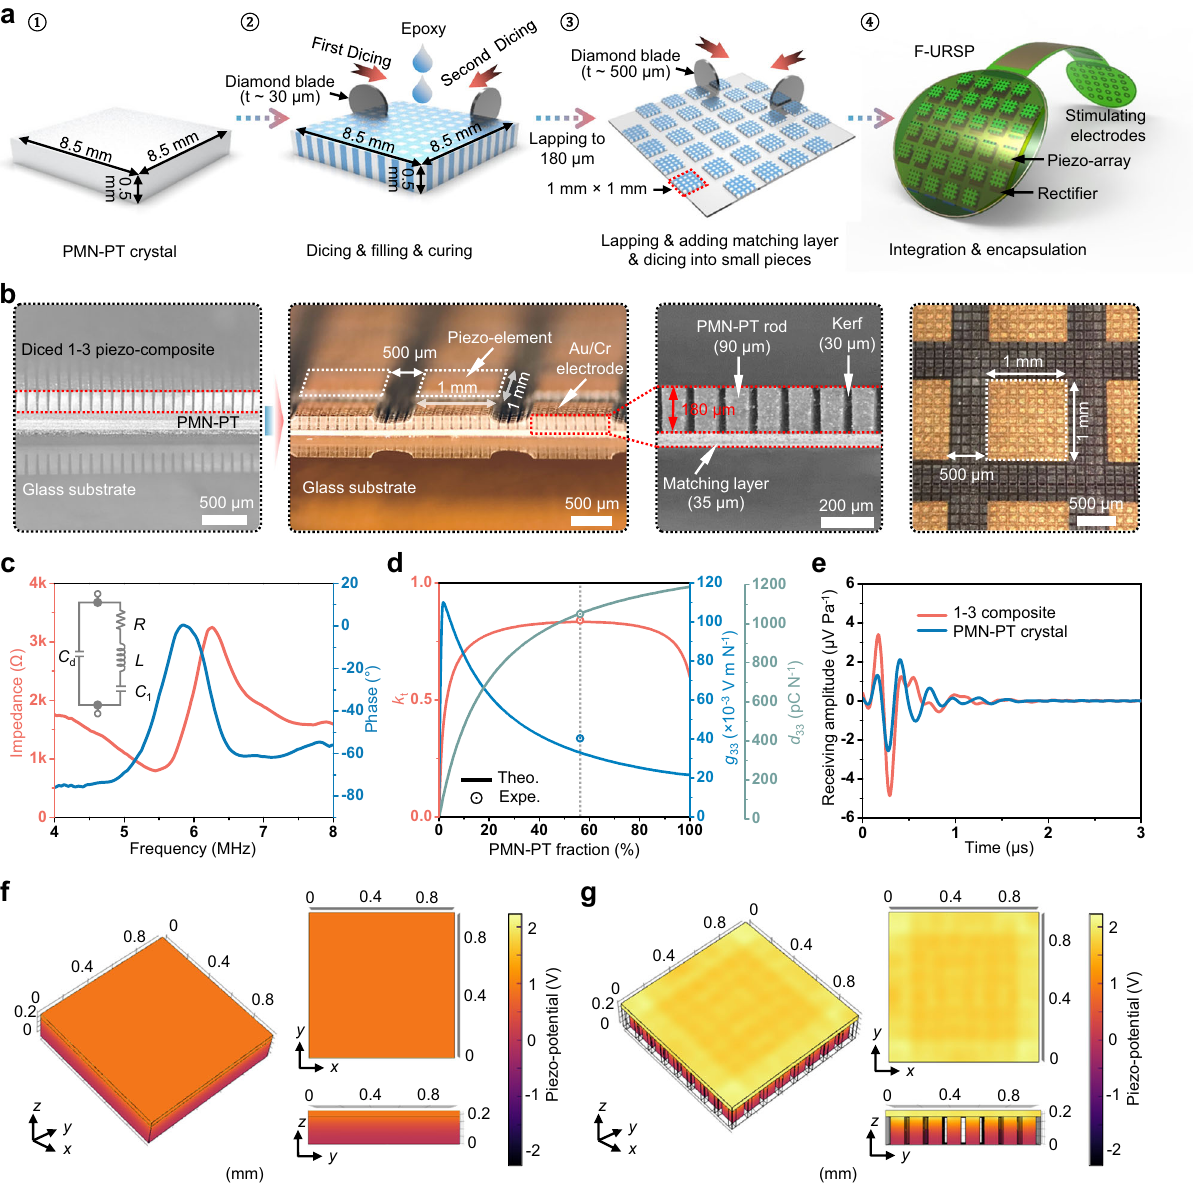
Fig. 2 Structural optimization and simulation of the F-URSP. a Schematic diagram showing the preparation process of the PMN-PT 1-3 composite for the harvesting array using a dicing-and- fi lling technology. b Photographs of the diced PMN-PT 1-3 composite and the prepared harvesting piezo-elements. The composite consists of 90- μ m-wide PMN-PT rods and 30- μ m-wide kerfs. Each element possesses a 1 mm × 1 mm element footprint with a spacing of 0.5 mm. c Impedance and phase angle spectra of a 1-3 composite piezo-element. Inset: equivalent RLC circuit diagram of the piezo-element. d Theoretically calculated and experimentally measured electromechanical coupling coef fi cient ( k t ), piezoelectric voltage coef fi cient ( g 33 ), and piezoelectric constant ( d 33 ) of the prepared 1-3 composite. The lines represent the theoretically calculated (Theo.) values and the symbols represent the experimentally measured (Expe.) values. e Simulated receiving sensitivity of the bulk PMN-PT piezo-element ( ∼ 2.56 μ V Pa − 1 ) and 1-3 composite element ( ∼ 4.87 μ V Pa − 1 ). f , g Simulated piezo-potentials inside a bulk PMN-PT piezo-element ( f ) and a 1-3 composite element ( g ) induced by the same acoustic pressure (0.5 MPa). Source data are provided as a Source data fi channels are functional. The mean of voltage ef fi ciency value is ~11.3%, with a standard deviation (SD) of 0.75% (Supplementary Fig. 9). The performance arising from the optimization of the 1-3 composite structure ensures high sensitivity in further electrical stimulation. Another important metric for assessing the perfor- mance of the piezo-array is the power density, which indicates the amount of energy that the device can provide. A series of voltage measurements were therefore performed when the device was connected to various external loads (Supplementary Fig. 10). As